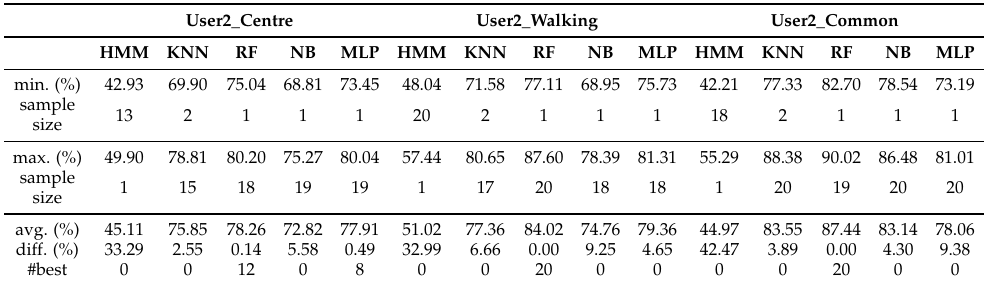
Table 4. Summary of the data shown in Figure 8. The rows for minimum (min.), maximum (max.), average (avg.), and difference (diff.) are given in percentages of successful classification experiments. The row labeled as size is for the corresponding sample size. The row labeled as #best is for the number of times the corresponding algorithm provided the best